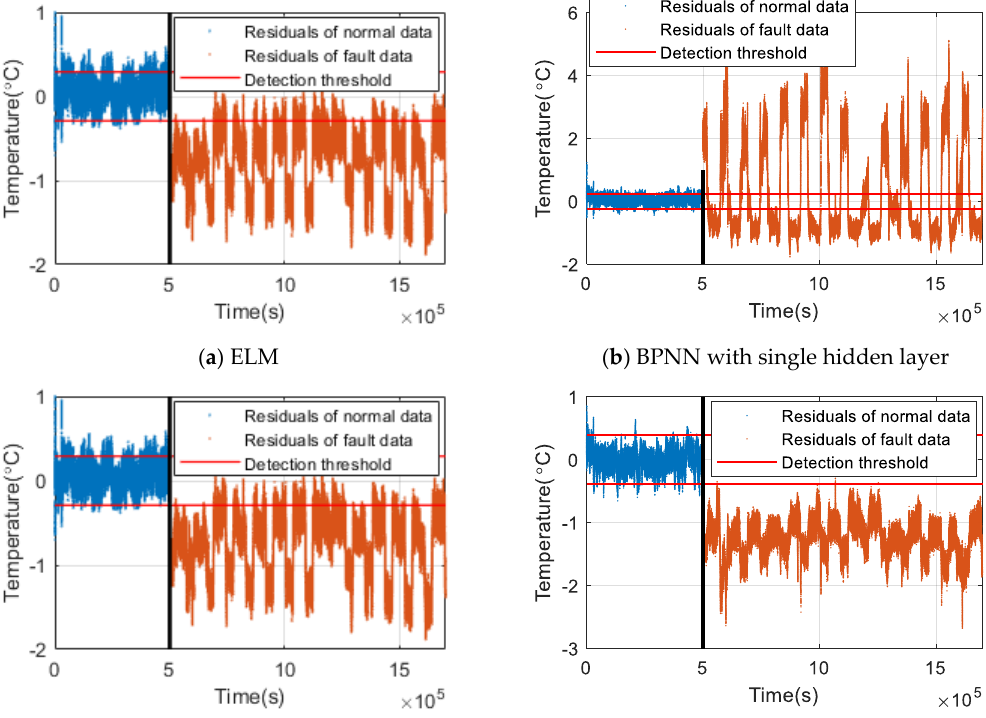
Figure 20. Fault early warning performance of comparative methods. Table 4. Performance comparison of different modeling methods.